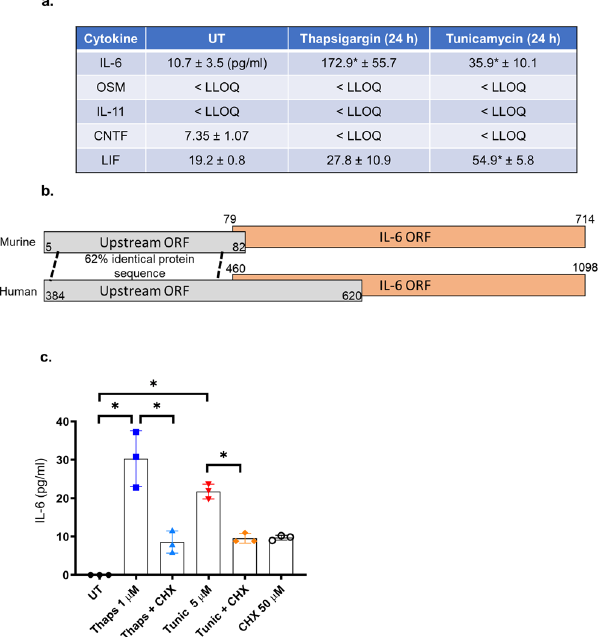
Figure 2. Regulation of IL-6 family proteins during ER stress. ( a ) Wild type primary murine astrocytes were stimulated with 1 µ M thaps or 5 µ M tunic for 24 h. The cell culture media were then analyzed by ELISA. Lower limit of quantitation (LLOQ). ( b ) Illustration of the murine and human IL-6 transcript showing the presence of a predicted upstream open reading frame (ORF). ( c ) Primary astrocytes were treated with cycloheximide (CHX) (50 µ M) for 30 min followed by the addition of thaps (1 µ M) or tunic (5 µ M) for 24 h. Media were then analyzed by ELISA for IL-6. Data are means ± SD, N = 3, * P ≤